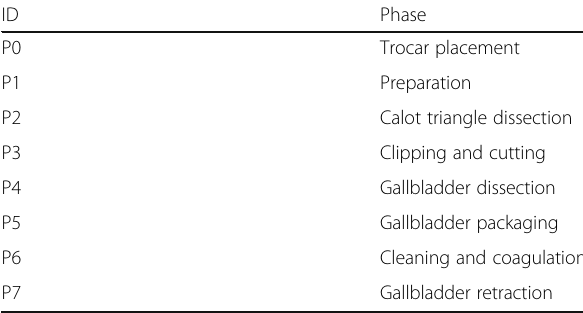
Table 1 List of phases in the